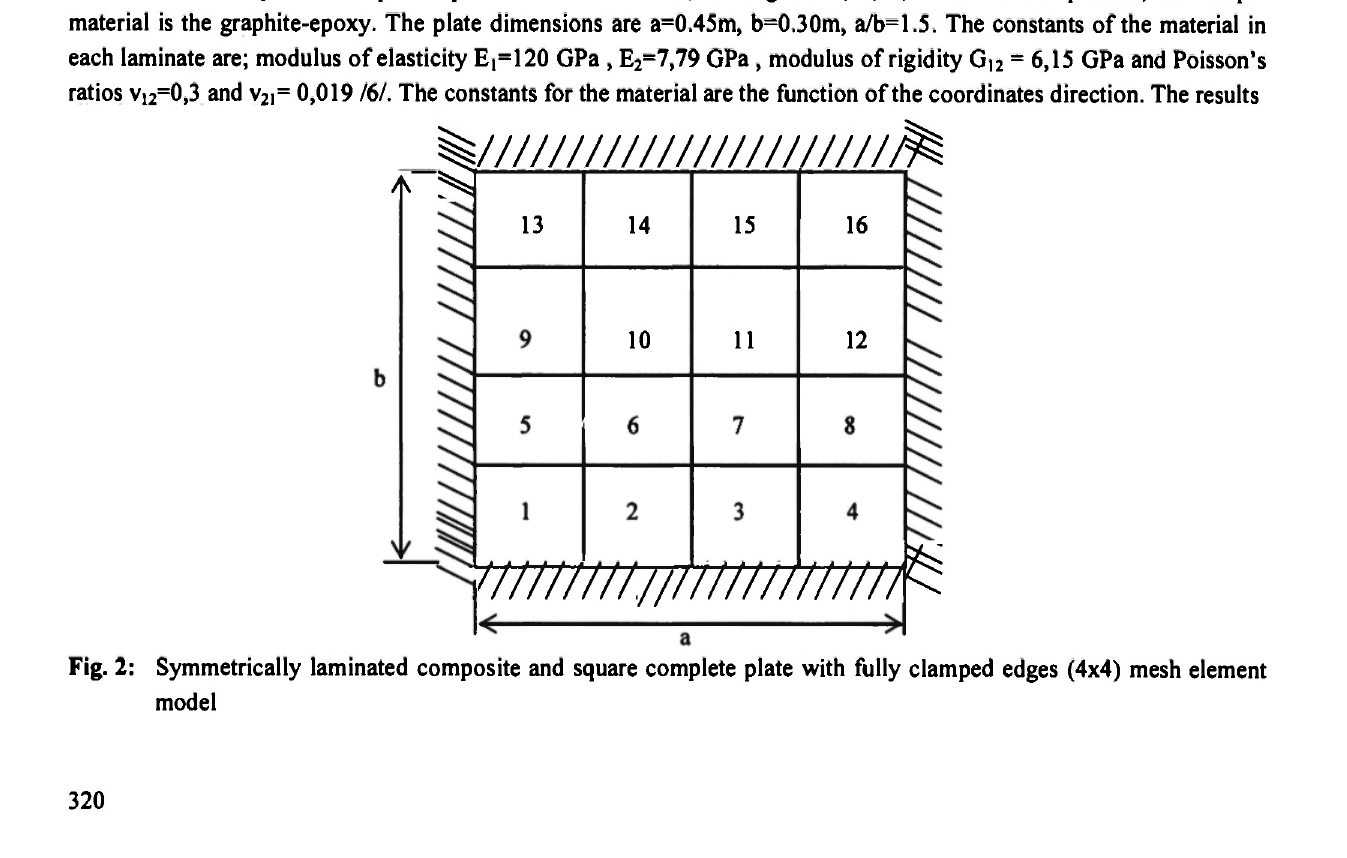
Fig. 2: Symmetrically laminated composite and square complete plate with fully clamped edges (4x4) mesh element model